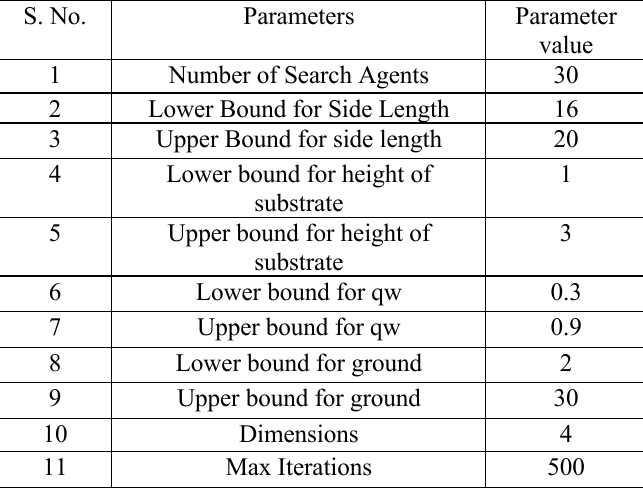
Table 2: Input Parameters of WOA